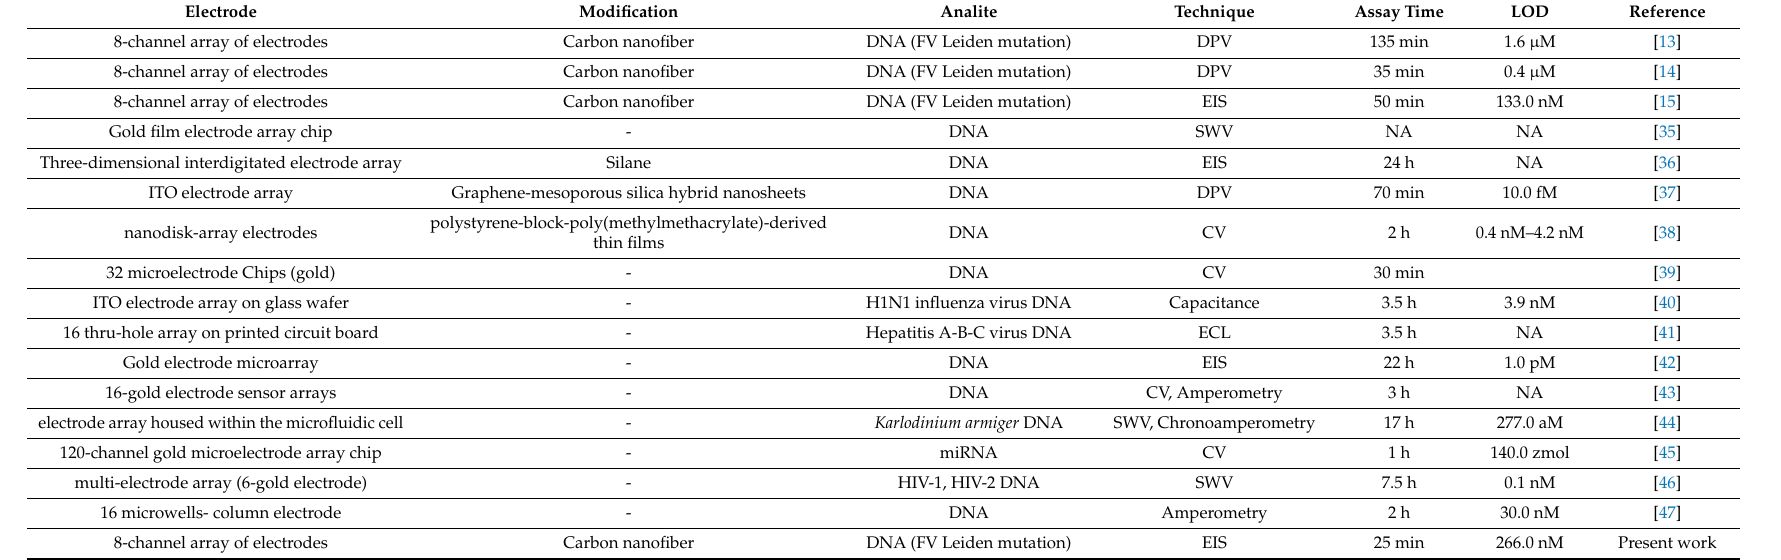
Table 4. The earlier studies developed for the detection of DNA by the array of electrodes in contrast to the present